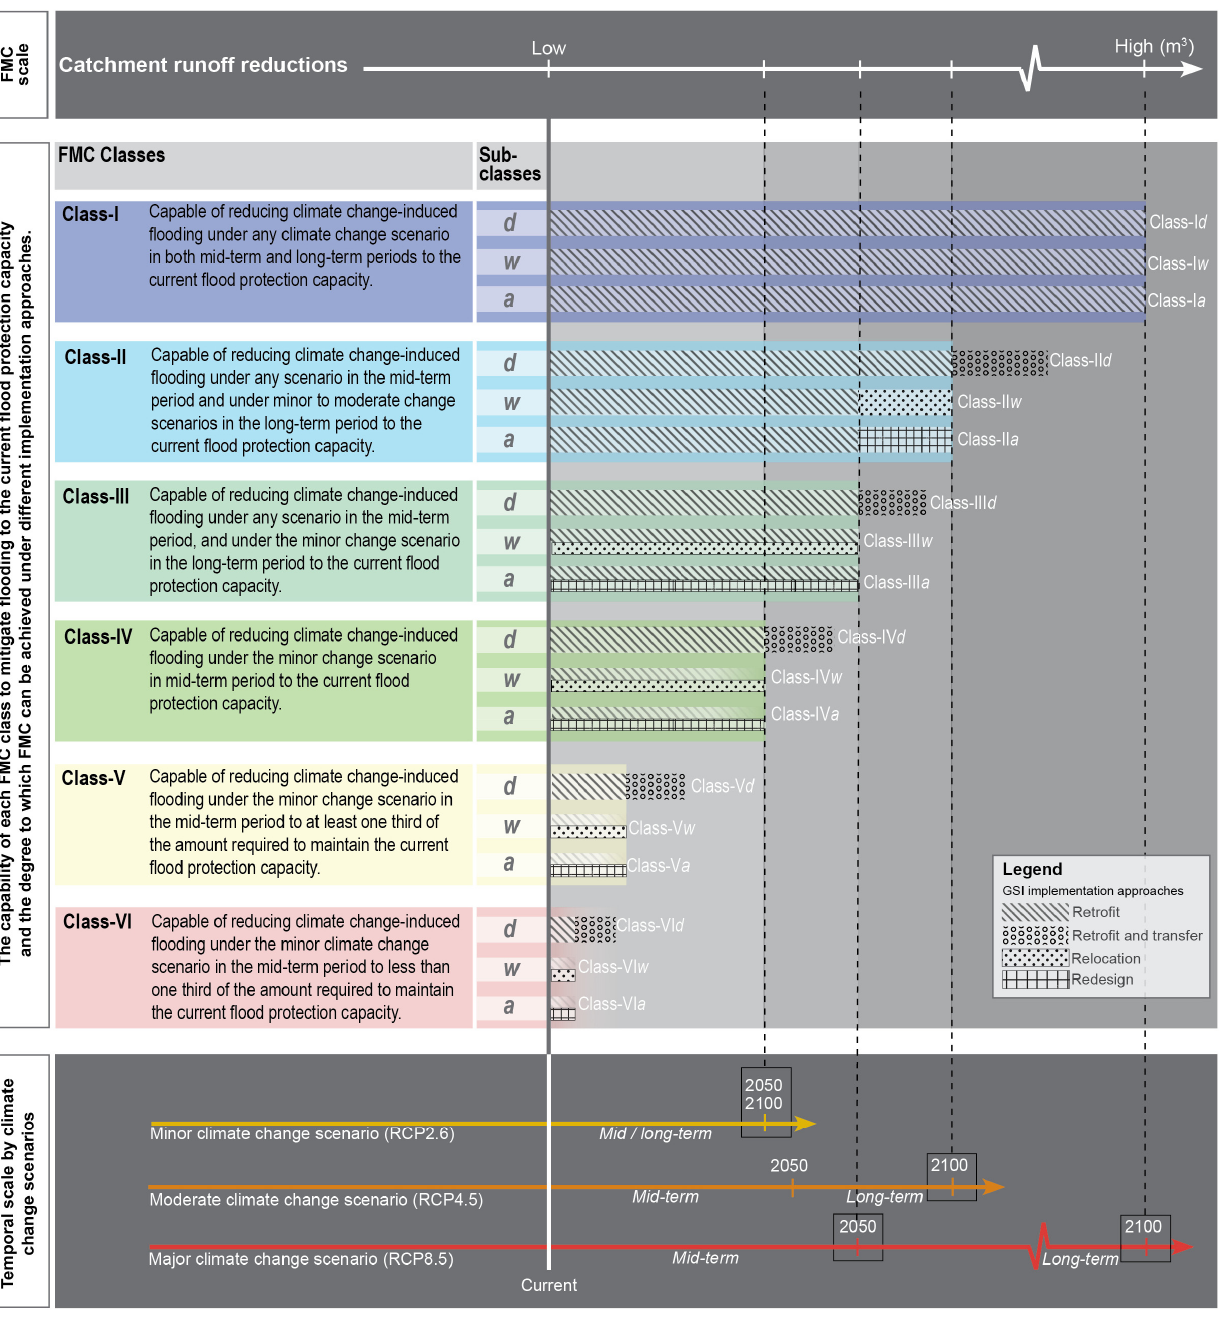
Figure 8. The FMC classification system groups SWM zones into six classes according to the extent to which they can reduce climate change-induced flooding to the current flood protection capacity by climate change scenario and period. Then, zones are categorised into different sub-classes according to their key limiting factor: d = drainage area, w = high groundwater, and a = potential GSI area. The outputs of the classification system have implications for implementation approaches through time (illustrated by hatch patterns on the right side of the classification table). Bar charts shown in pastel colours indicate the required catchment runoff volume reductions to meet a flood protection objective under different climate change scenarios and periods indicated in the lower dark grey box.